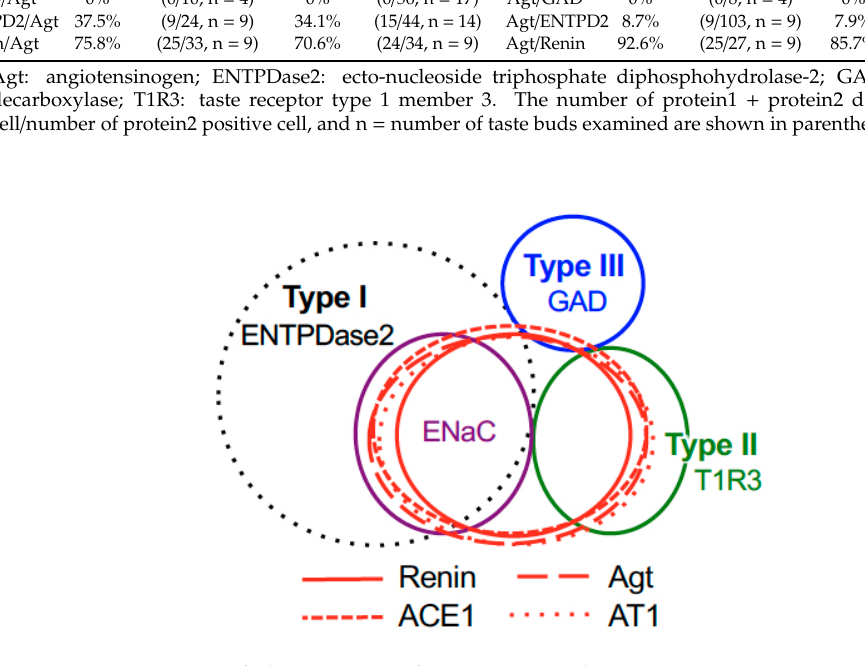
Figure 5. Summary of the patterns of co-expression between renin, angiotensinogen (Agt), angiotensin-converting enzyme-1 (ACE1), angiotensin II type 1 receptor (AT1) and type-specific markers of taste cells [nucleoside triphosphate diphosphohydrolase-2 (ENTPDase2) for cell type I, taste receptor type 1 member 3 (T1R3) for cell type II, and glutamate decarboxylase 67 (GAD) for cell type III] in both the fungiform and circumvallate papillae of mice.